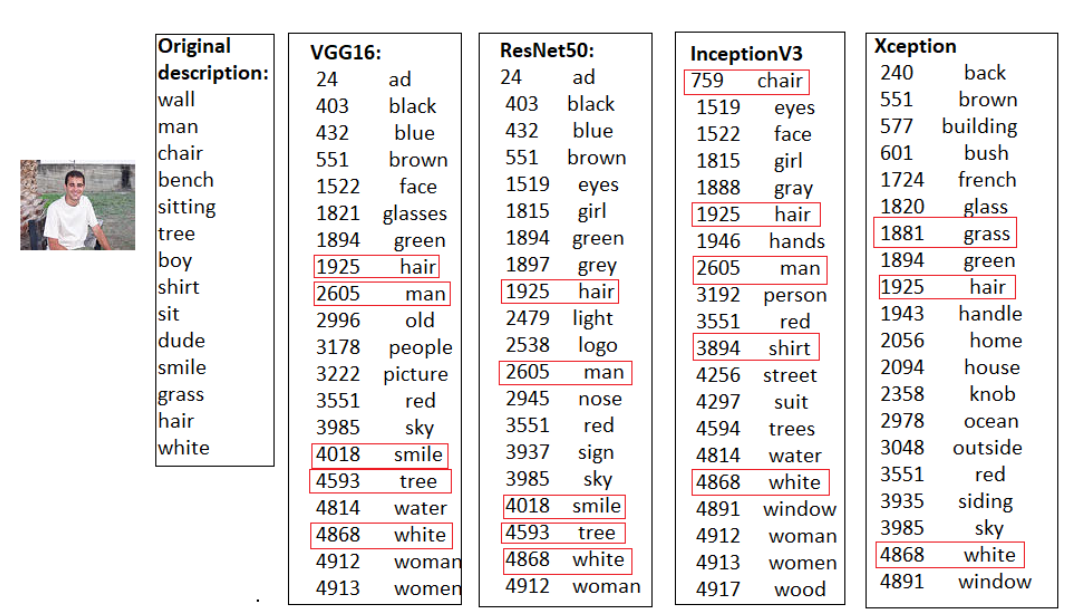
Figure 7. ESP Game Data set: Comparison between original and generated description using different types of image features. Similar descriptors are marked in red